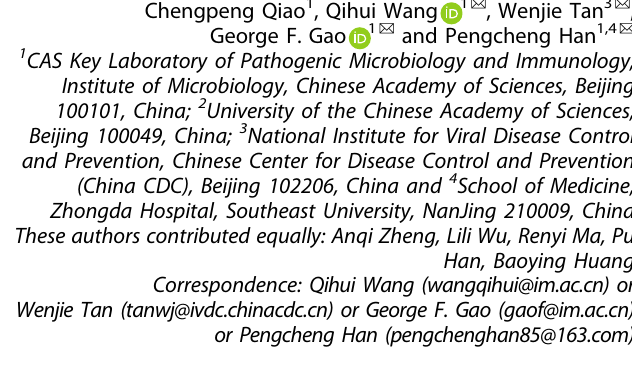
Fig. 1 Binding and neutralization activities of an enzymatic activity-eliminated hACE2 mutant against SARS-CoV-2 WT and variants, and the complex structure of it with Gamma-RBD. a Soluble mFc-tagged hACE2 mutants were captured by anti-mIgG Fc antibodies immobilized on the CM5 chip. Serially diluted SARS-CoV-2 RBDs were fl owed over the chip surface to assess binding to the hACE2 mutants. hACE2-WT was used as a control. The raw and fi tted curves are shown as dotted and solid lines, respectively. The binding af fi nities ( K D ) are shown as mean ± SEM of three independent experiments. b The enzymatic activity of hACE2-T27F-R273Q was assessed using the ACE2 Activity Fluorometric Assay Kit according to the manufacturer ’ s instructions. NC, negative control (buffer only). Relative fl uorescence values were determined for 30 min at 5 min intervals. Representative data (mean of triplicates, n = 3) from three independent experiments are shown, and the bars represent the SD. c hFc-tagged hACE2-WT and mutants were captured on protein A chip, and serial dilutions of the RBDs of SARS-CoV-2 WT, Alpha, Beta, Gamma, mink-Y453F, mink-F486L, and mink-N501T were fl owed over the chip surface to assess binding to the hACE2 proteins. The K D values are summarized in the table (mean ± SEM of three independent experiments), and the binding curves are shown in Fig. S2. d GFP-tagged SARS-CoV-2 WT and variants pseudoviruses were incubated with two-fold serial dilutions of hACE2-WT, hACE2-T27F, or hACE2-T27F-R273Q protein. Then, the mixtures were added to Vero cells. After 15 h, the infected cells were counted with a CQ1 Confocal Quantitative Image Cytometer. The experiments were performed thrice with three replicates ( n = 3) in each experiment. The curves show representative data, and the IC 50 values are the mean ± SEM of three independent experiments. e 50 – 80 plaque-forming unit (PFU) of authentic WH01, Alpha or Beta were incubated with two-fold serial dilutions of hACE2-WT or hACE2-T27F-R273Q protein. Then, the mixtures were added to Vero cells. After 1 h, the cellular supernatant was discarded with the addition of DMEM medium containing Avicel. After another 72h, the numbles of plaques were counted. The experiments were performed twice. The 50% plaques reduction neutralization test titers (PRNT 50 ) values were represented as mean ± SD with the bar representing the SD value. n.s, not signi fi cant (multiple t tests). f The overall complex structure of hACE2-T27F-R273Q bound to Gamma-RBD. hACE2-T27F-R273Q and Gamma-RBD were colored in green and blue, respectively. g The detailed interaction contributed by F27 on hACE2-T27F-R273Q, and the residues participated in the interaction were labeled with a cutoff of 4.5 Å. h The detailed interaction contributed by T417, K484, and Y501 on Gamma-RBD, and the residues involved in the interaction were labeled with a cutoff of 4.5